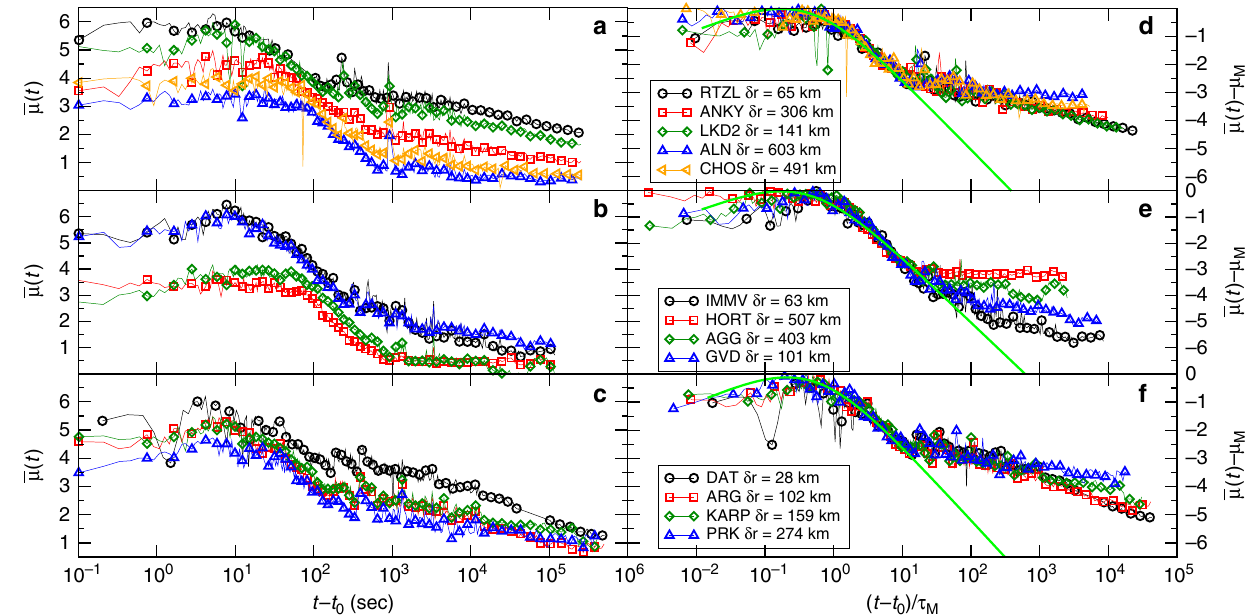
Fig. 4 The average envelope function at different epicentral distances. a – c The average envelope function (cid:2) μ ð t Þ obtained from the signal recorded at seismic stations at different epicentral distances δ r from the mainshock after the Zakynthos earthquake ( a ), Crete earthquake ( b ), and Kos earthquake ( c ). The station name and epicentral distances are reported in the fi gure legend. d – f The same quantity of the corresponding left panel plotted after the rescaling (cid:2) μ ð t Þ − μ M and ( t − t 0 )/ τ M , with τ M = 11.4, 27.7, 16.1, 57.7, and 50.8 s for the stations RTZL , ANKY , LKD 2, ALN , and CHOS , respectively, for the Zakynthos earthquake ( d ), τ M = 16.5, 57.7, 55.4, and 18.5 s for the stations IMMV , HORT , AGG , and GVD , respectively, for the Crete earthquake ( e ), and τ M = 22.6,